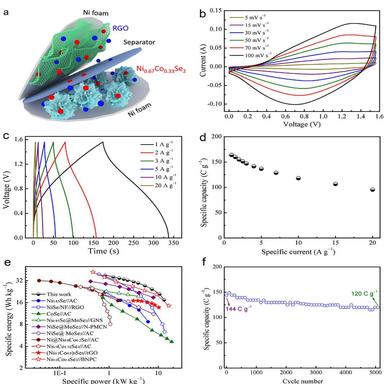
(a) Schematic of the device structure of the Ni0.67Co0.33Se2//RGO HSC. (b) CV at different scan rates, (c)) GCD curves at different specific currents, (d) specific capacity as a function of specific current, (d) Ragone plot and (e) cycling performance of the Ni0.67Co0.33Se2//RGO HSC device.